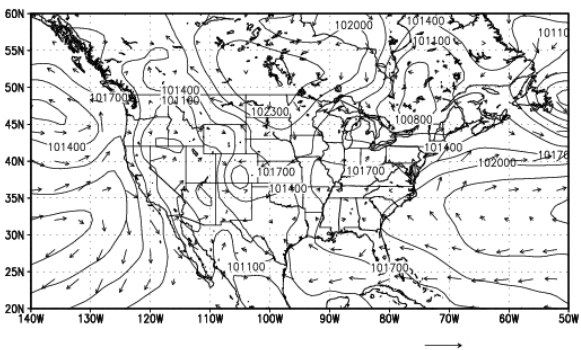
Figure 3 : Sea level pressure and surface winds at 10m level at 00Z 28 June